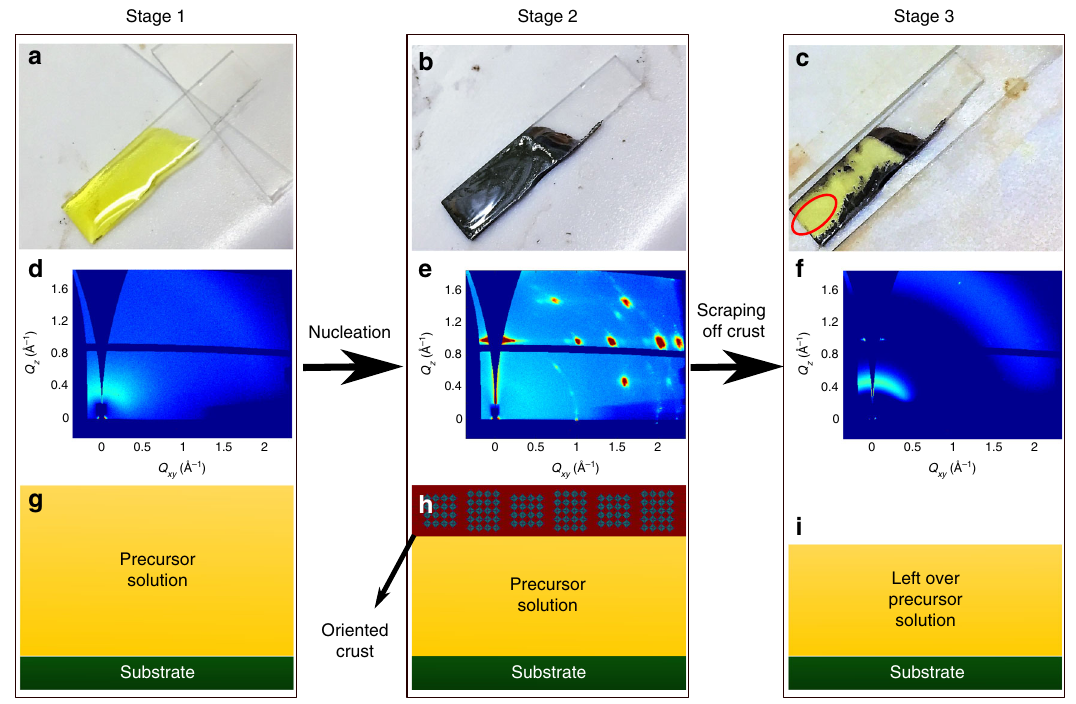
Fig. 3 Optical images and GIWAXS patterns and illustrations of top-crust scraping test. In stage 1, the precursor solution is deposited on a glass substrate. Optical image a and GIWAXS pattern d shows yellow liquid with no crystalline species g . In stage 2, immediately after the surface turns dark upon thermal annealing b , GIWAXS pattern e shows a vertically oriented BA 2 MA 3 Pb 4 I 13 top-crust h . The top-crust is removed by a blade-scraping setup in stage 3 to expose the yellow precursor solution underneath that has not yet crystallized c . GIWAXS pattern of the exposed spot f shows diffuse scattering only from its non-crystalline left-over precursor solution i